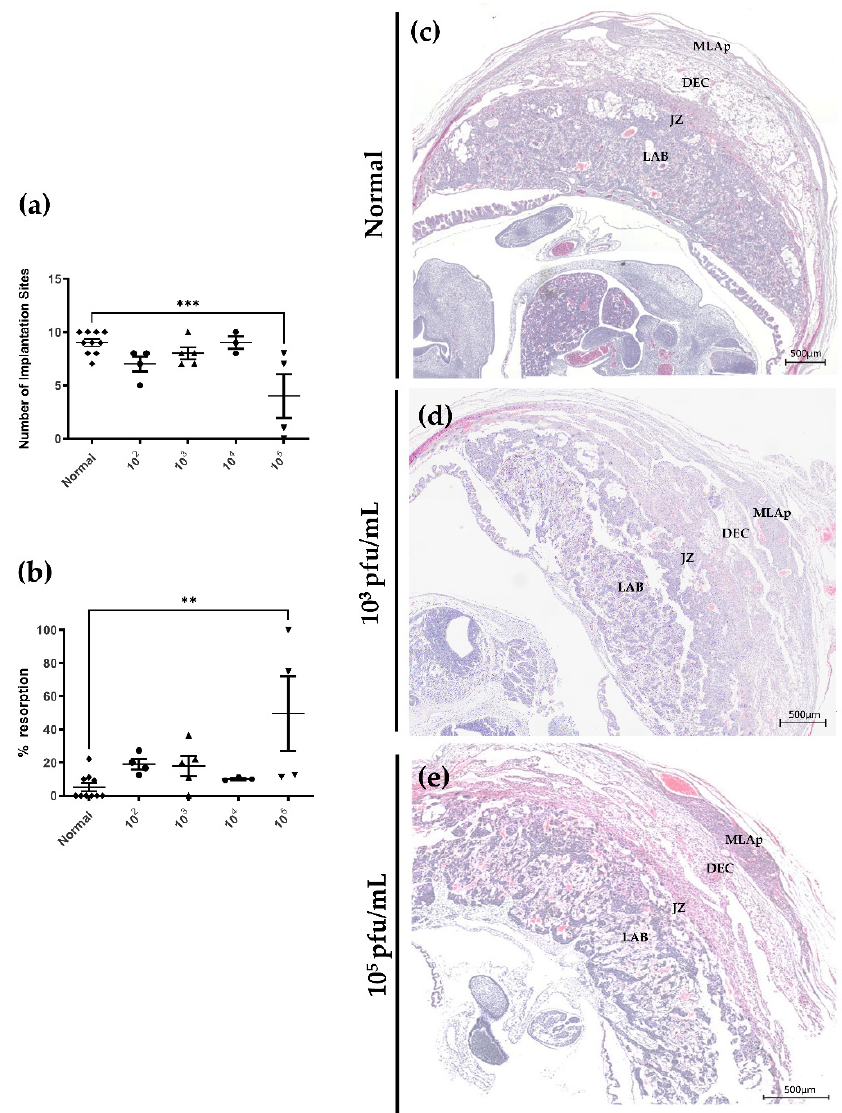
Figure 5. Pregnancy outcomes are affected by HSV-2 infection at gd12.5 resulting in placental pathology. ( a ) HSV-2 infection resulted in reductions in the number of healthy implantation sites compared to controls at gd12.5 ( n = 3–10 mice per group). ( b ) Percent resorption was increased compared to controls in HSV-2-infected mice ( n = 3–10 mice per group). ( c ) Implantation sites from normal gd12.5 mice consisted of 4 clearly defined and organized placental layers. ( d ) In mice infected with low dose HSV-2 (10 3 pfu/mL), placental layers remained distinct but there was evidence of tissue dissociation. ( e ) In mice infected with high dose HSV-2 (10 5 pfu/mL), placental layers were highly disorganized and tissue disintegration was evident. MLAp: mesometrial lymphoid aggregate of pregnancy; DEC: decidua; JZ: junctional zone; LAB: labyrinth. Data expressed as mean ± SEM. ** p < 0.01, *** p <